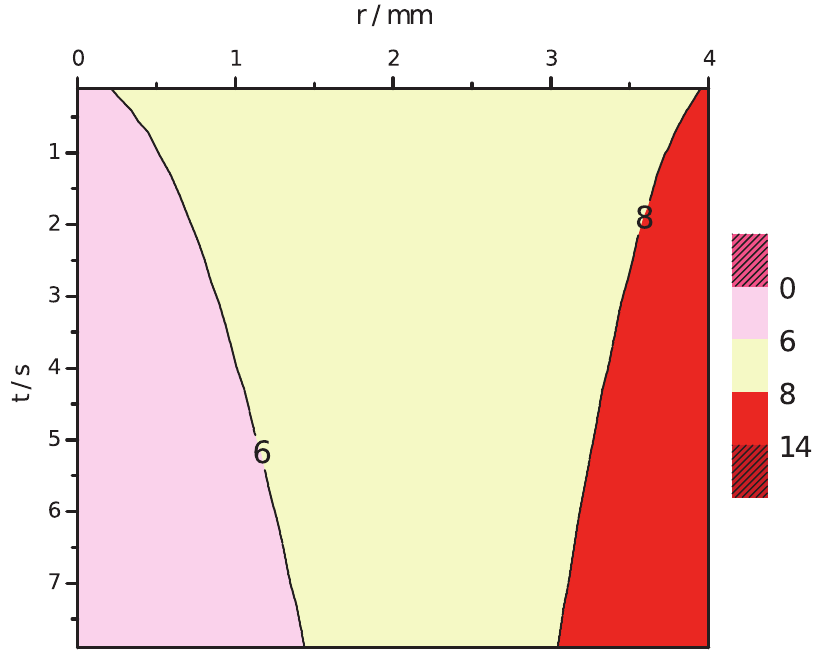
Figure 4. Evolution of the anodic acid (pink) and cathodic basic (red) pH fronts. Space-time prediction of pH variation under ECT (anodic and cathodic contour lines at pH 6 and 8, respectively), at 8 pulses, 400 V , 300 m s , 1 Hz .